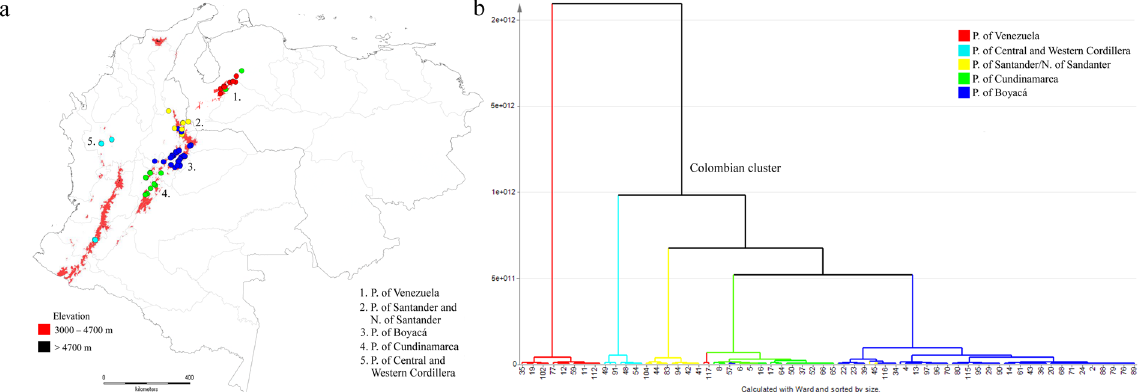
Figure 3. Clustering of Espeletia species based on metabolic fingerprinting in negative ionization mode of 120 plant samples analyzed by UHPLC-UV-HRMS. ( a ) Map of Colombia and Venezuela with species (represented as dots) colored according to their OPLS-DA groupings and ( b ) OPLS-DA dendrogram showing the clustering of species according to their páramo massifs of origin. Map created using DIVA-GIS software, version 7.5.0.0 available at